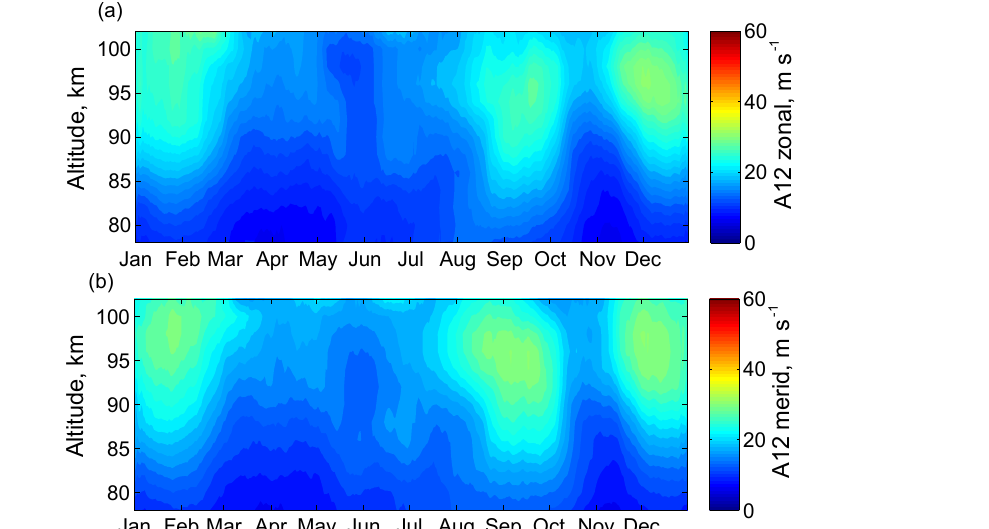
Figure 1. Amplitudes of semidiurnal tides at high latitudes extracted from meteor radar observations over Andenes. Panels (a, b) correspond, respectively, to the zonal and meridional components.